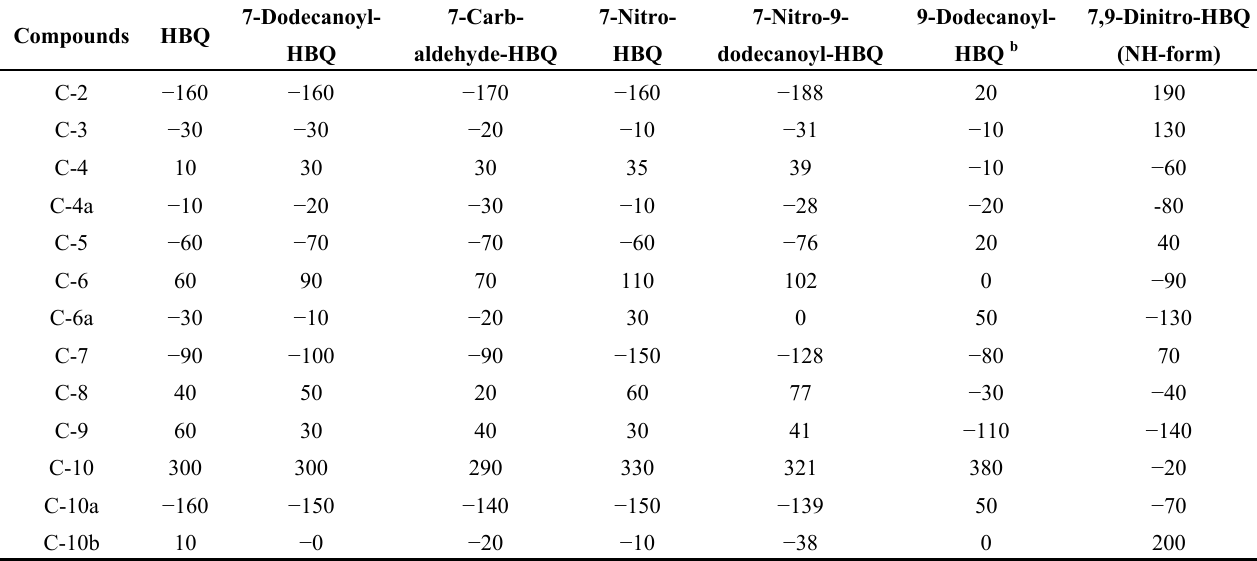
Table 3. Changes in 13 C nuclear shieldings due to OH bond length a changes